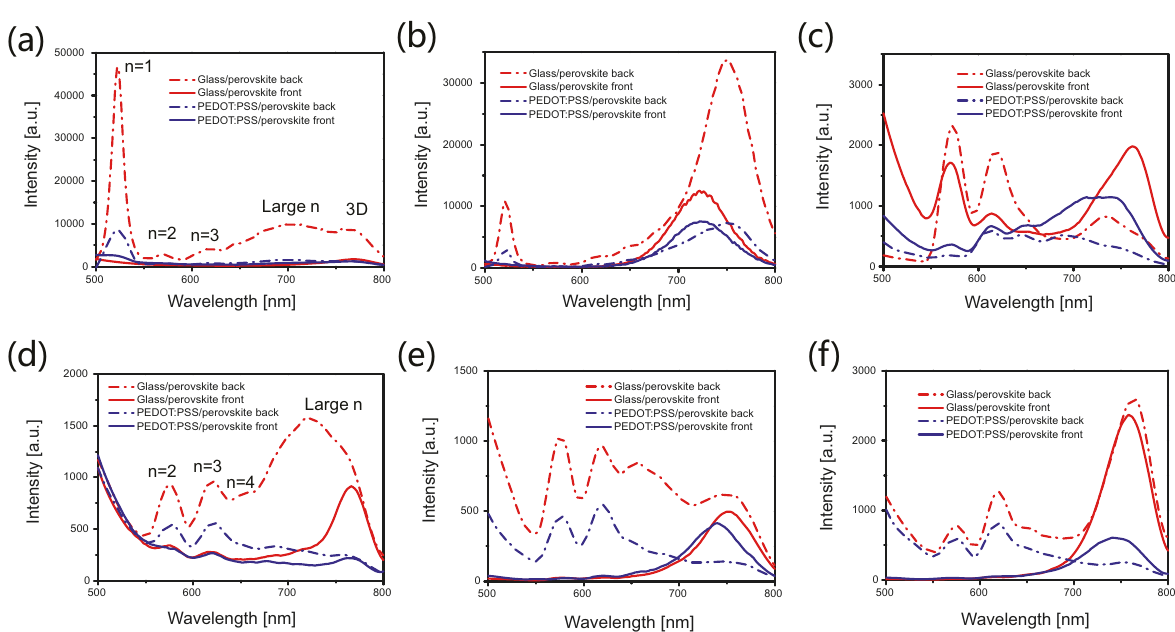
Fig. 3 Photoluminescence emission spectra of PEA-2D and iso-BA-2D perovskite fi lms on glass and glass/PEDOT:PSS substrate (excitation: 440 nm). a Naturally dried PEA-2D fi lm; b N 2 blow-dried PEA-2D fi lm; c N 2 blow-dried PEA-2D fi lm with MACl additive; d Naturally dried iso-BA-2D fi lm; e N 2